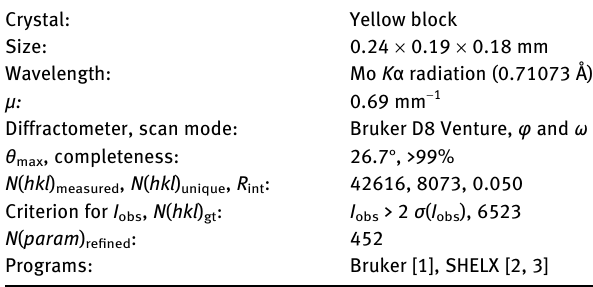
Table  : Data collection and